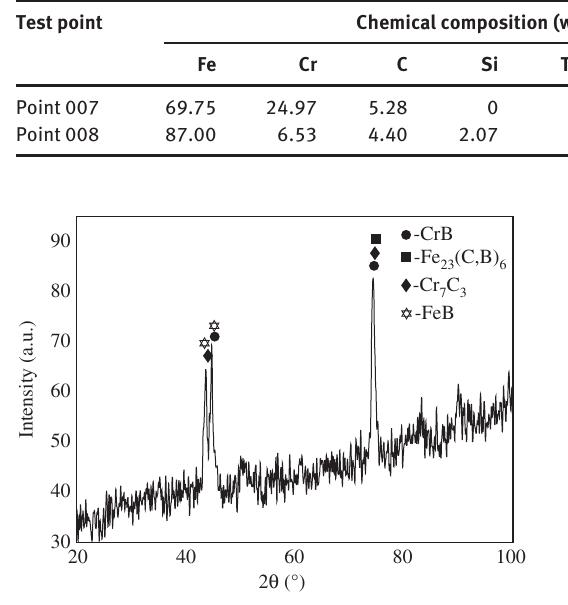
Figure 4 The XRD pattern for FeCrBC alloy cladding.